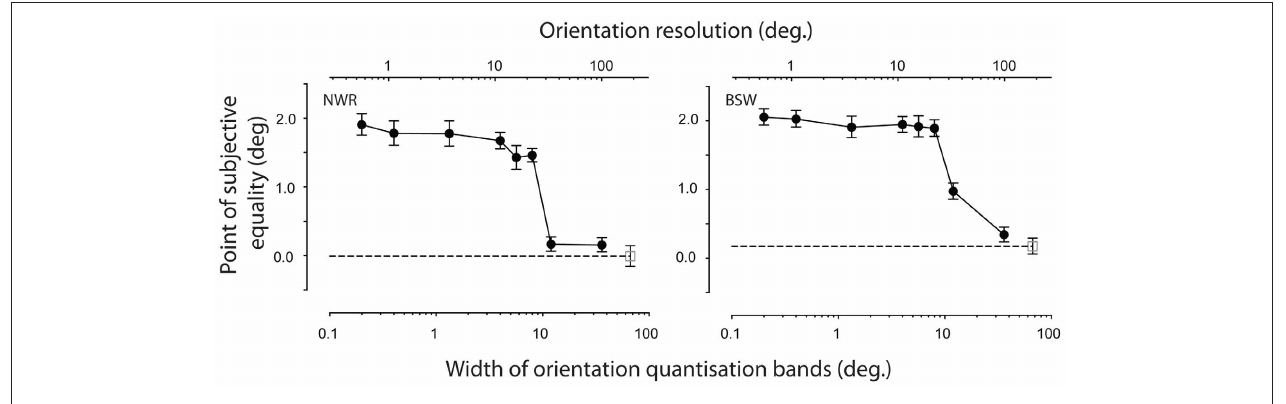
FIGURE 6 | Effect of quantizing the orientation gradient within the adapting texture. PSEs are plotted as a function of the width of each spatial bin, within which all texture elements were assigned a fixed orientation (filled symbols). The upper scale shows the corresponding